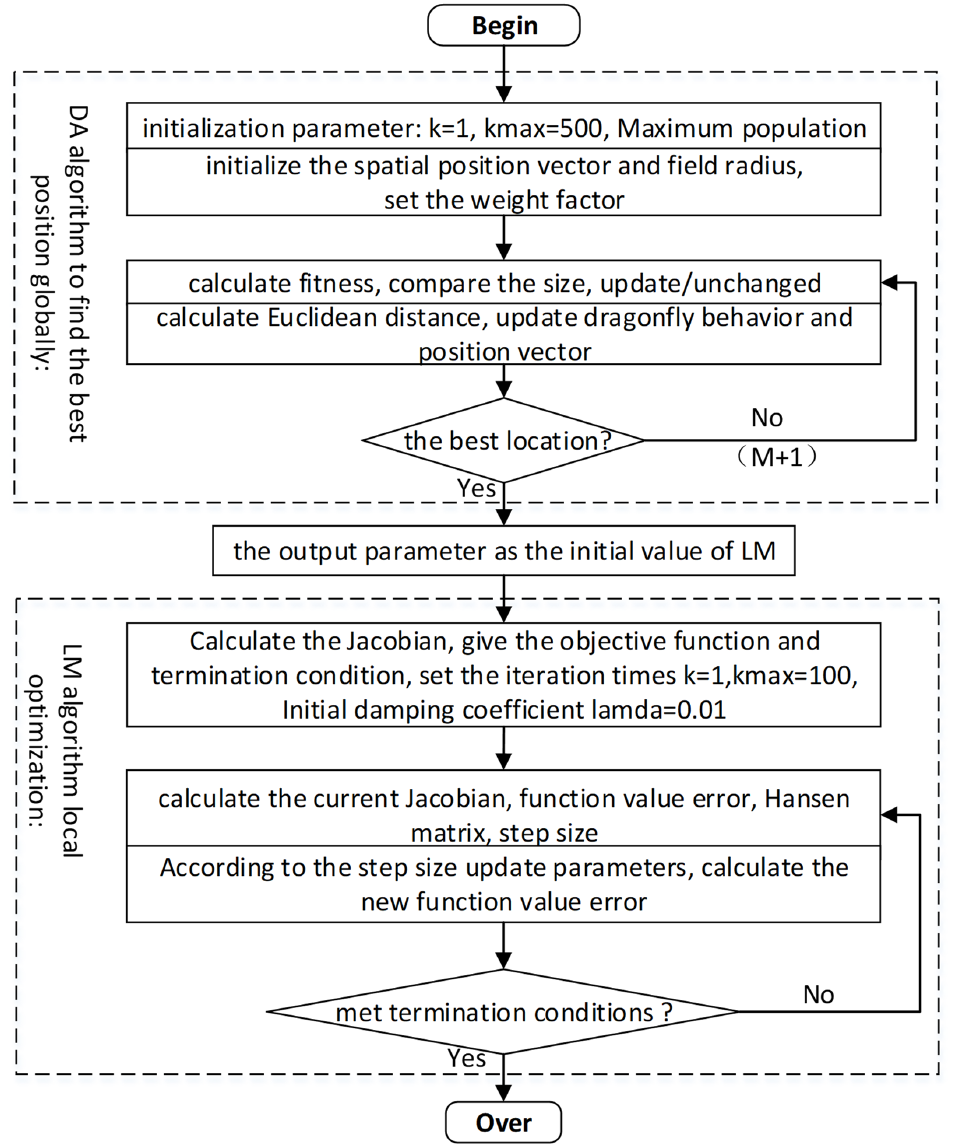
Figure 2. The flow chart of DA–LM